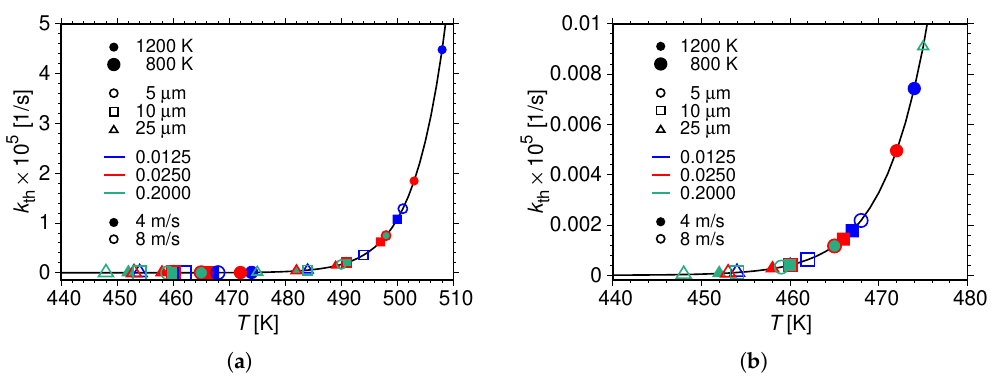
Figure 3. Rate coefficient of the thermal decomposition k th versus temperature (solid line) and final droplet surface temperatures for various initial conditions (symbols). ( a ) k th versus temperature. ( b ) Zoomed